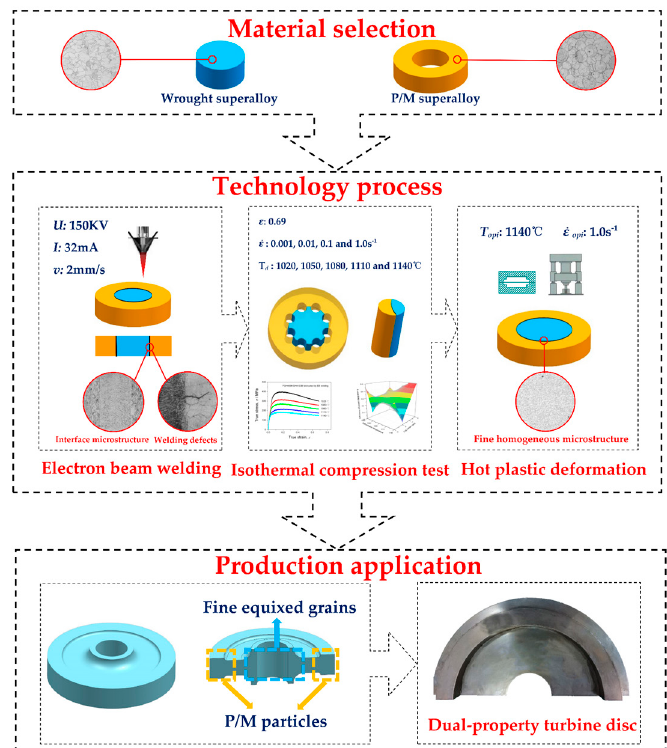
Figure 1. Schematic illustration of the fabrication for dual-property turbine disc in present research.